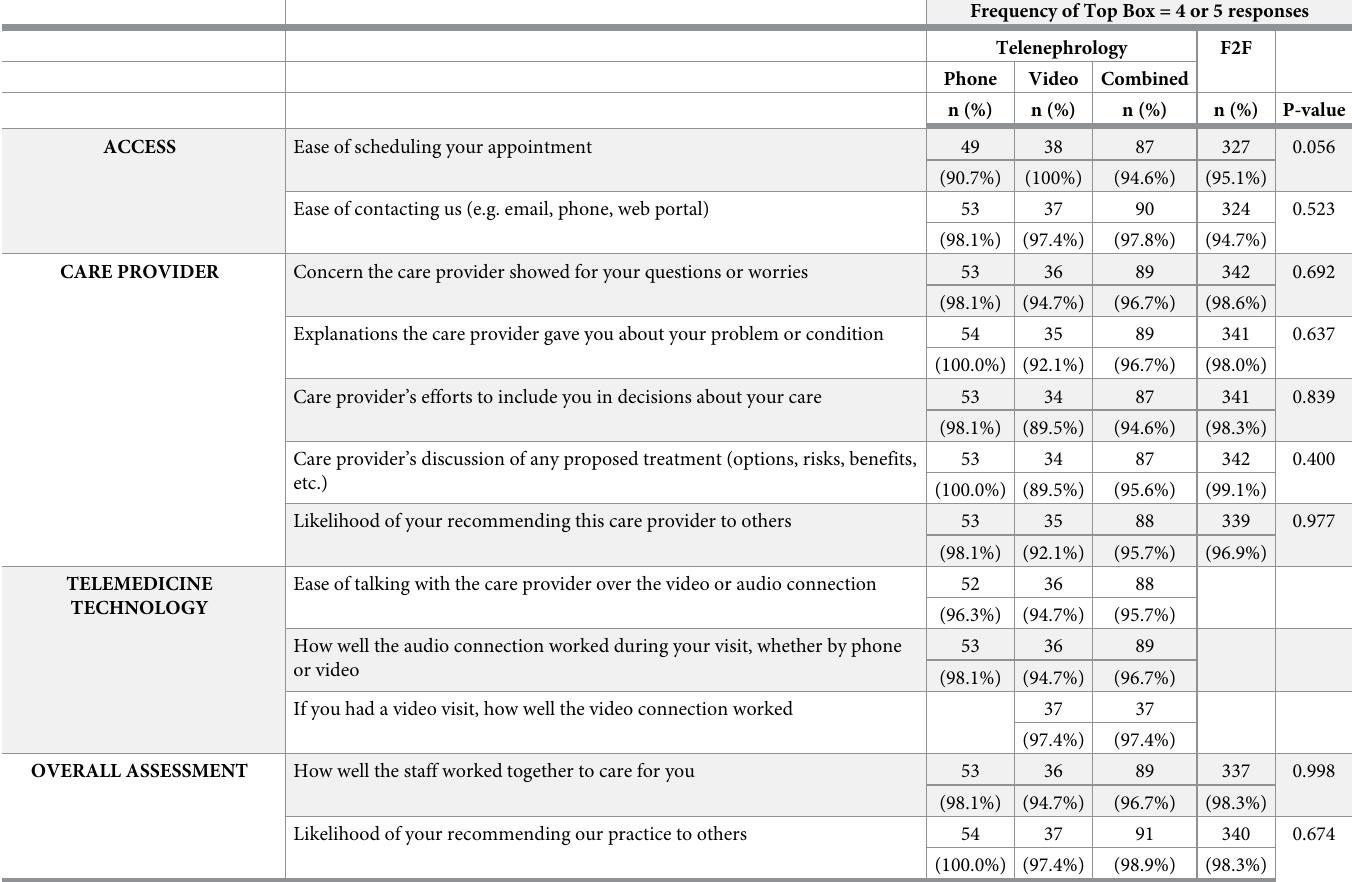
Table 3. Frequency of survey top box scores: Likert score of 4 (good) or 5 (very